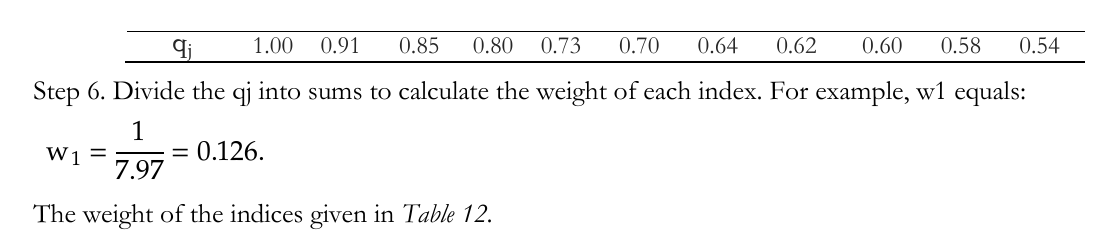
Table 10. Growth amounts of 𝐤